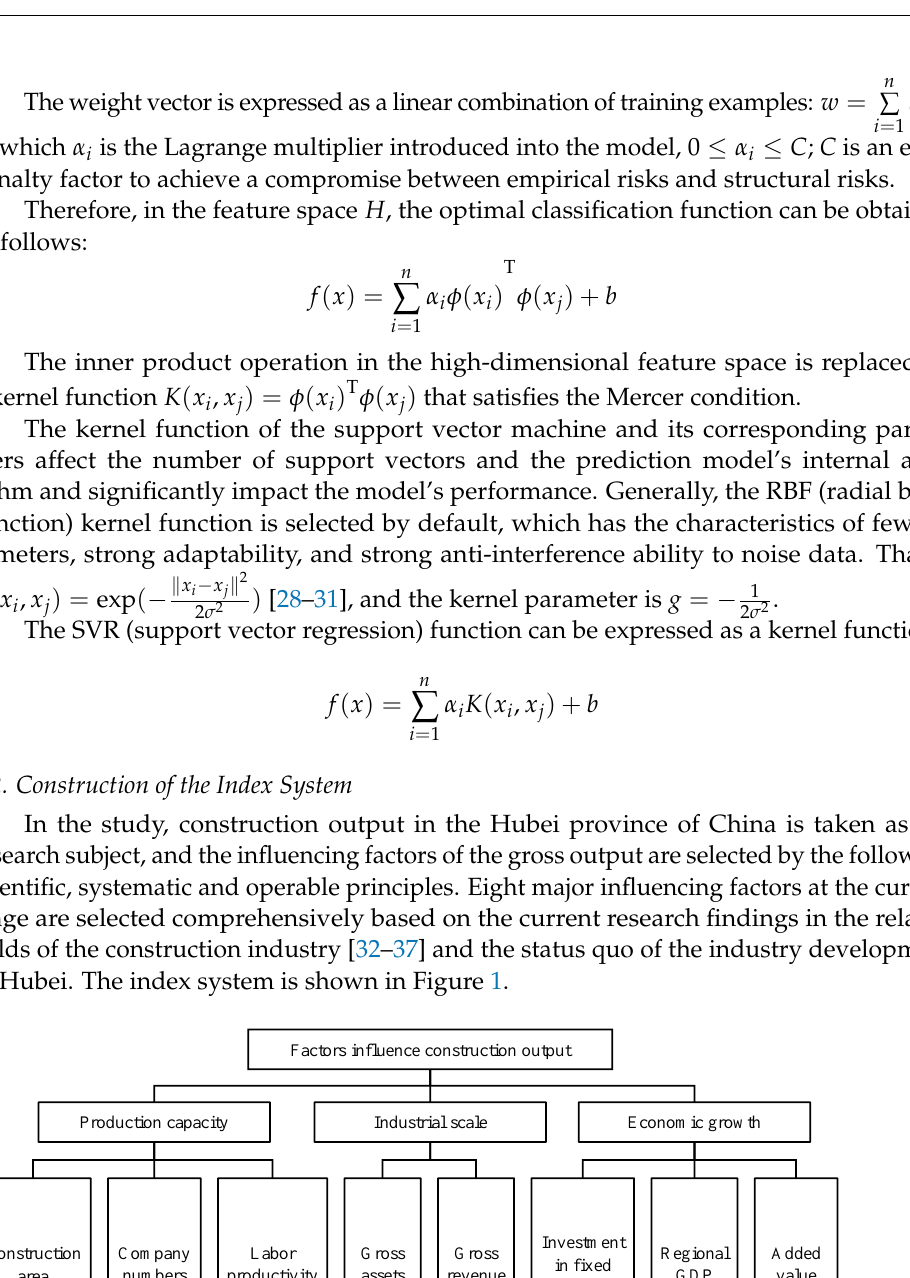
Table 2. Correlation of influencing factors.